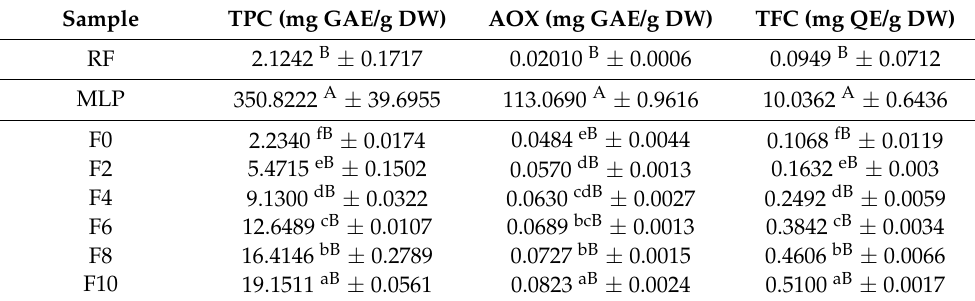
Table 6. Contents of TPC, AOX capacity, and TFC of raw ingredients, F0, and FRN